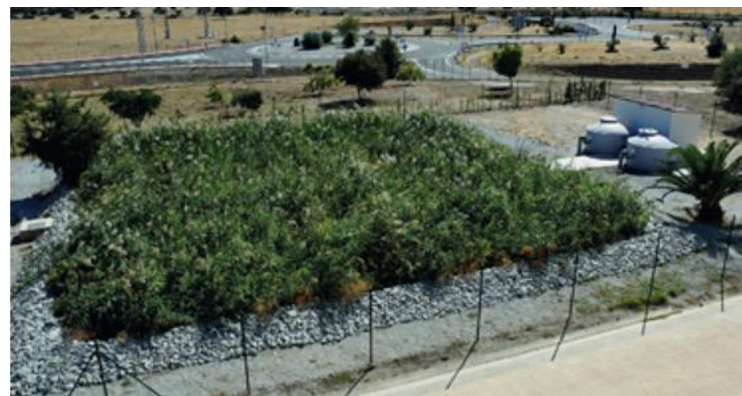
Figure 1. Treatment plant located in the CCMIJU, at the southwest of Spain.